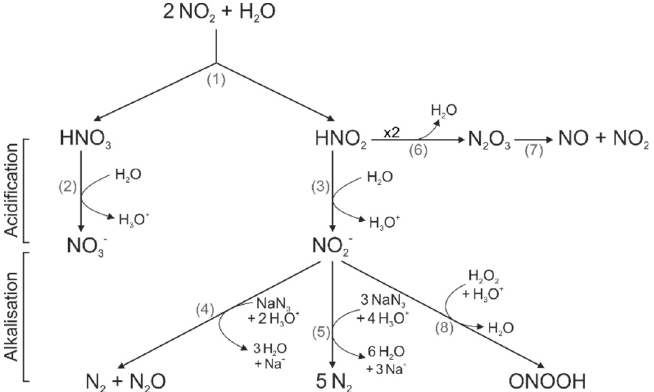
Figure 5. Schematic diagram of chemical species. The graphical reactions described in the text are represented to show acidification or consumption of acidic equivalents by NaN 3 or generation of peroxynitrous acid (ONOOH).